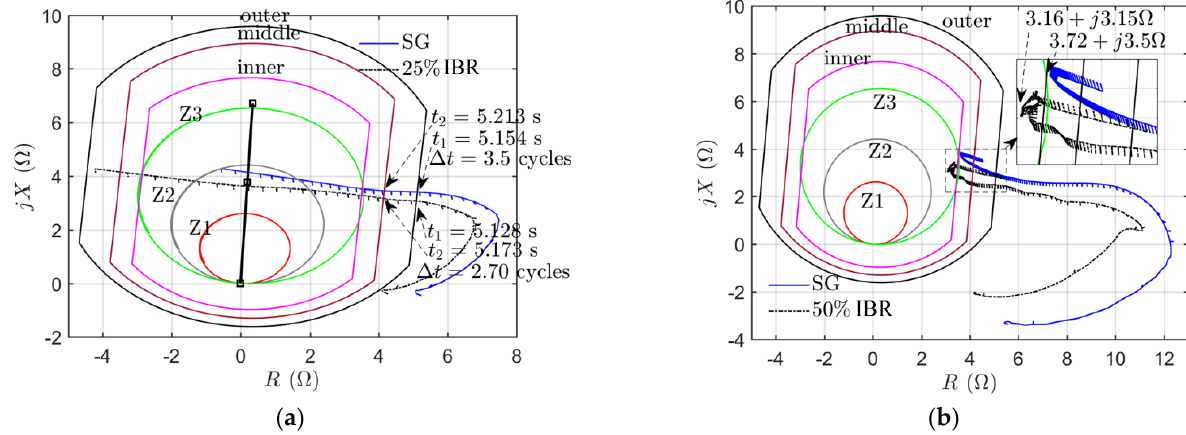
Figure 13. ( a ) Power Swing Blocking (PSB) misoperation due to faster swings under IBRs and ( b ) Out-of-Step-Tripping (OST) malfunction due to changed swing trajectory under IBRs.